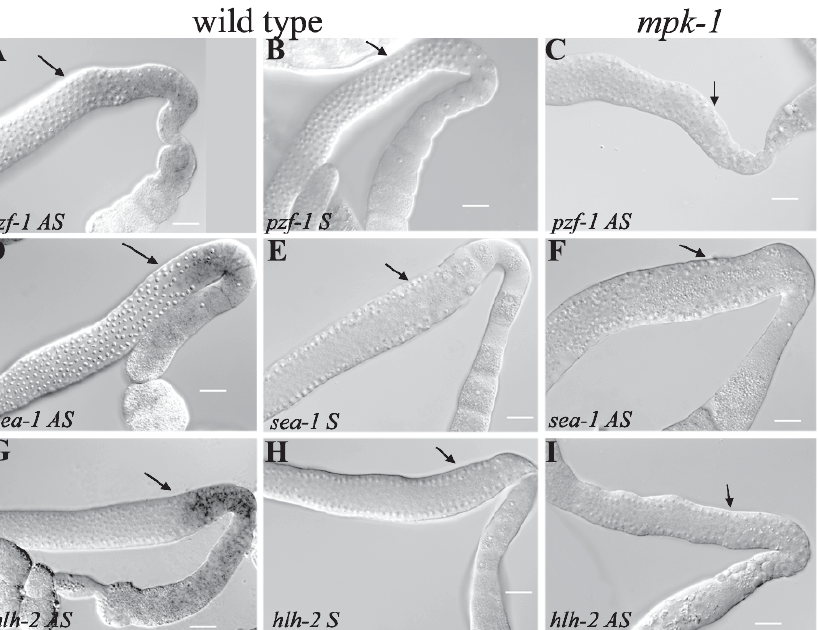
Figure 3. Candidate MPK-1 Signaling-Responsive Autosomal Genes Depend on mpk-1 for Expression RNA in situ hybridizations of N2 (A, B, D, E, G, and H) and mpk-1 (C, F, and I) gonads. Sense and AS probes correspond to three MPK-1 signaling- responsive genes on autosomes: pzf-1 (A–C), sea-1/tbx-18 (D–F), and hlh-2 (G–I). Only medial and proximal arm of gonads are shown; no staining was detected in the distal gonad for any probe. Arrow indicates location of late pachytene region. Scale bar, 20 l m.